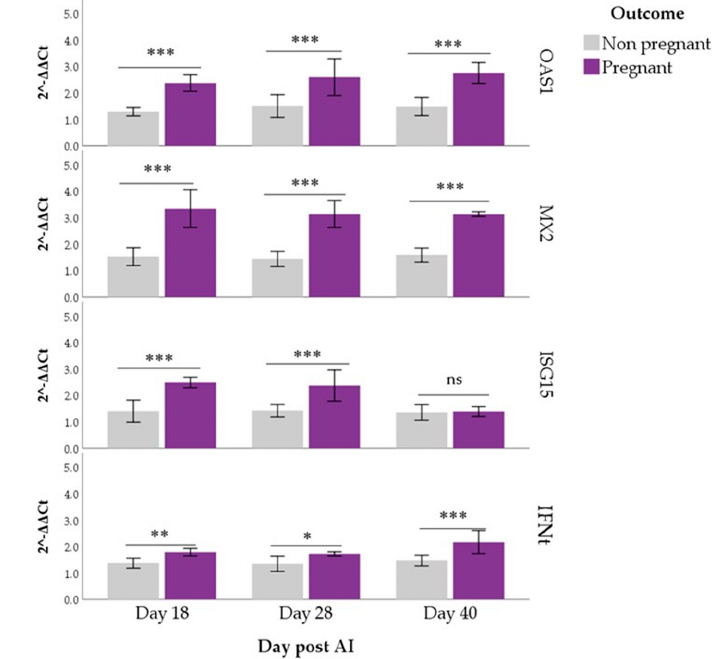
Figure 2. OAS1 , MX2 , ISG15 and IFNt expression in PMNs of pregnant and non–pregnant buffaloes. Asterisks indicate differences in expression between the Pregnant and Non-pregnant groups for each gene and each day post-artificial insemination (AI; ns: not significant, * p < 0.05, ** p < 0.01, *** p < 0.001). 3.3. Differences between the PBMCs and PMNs Expression in Pregnant Group Expression differences in the matrix were only found for ISG15, which was highest in PMNs at day 18 ( p < 0.001) and PBMCs at day 40 ( p = 0.001; Figure 3).